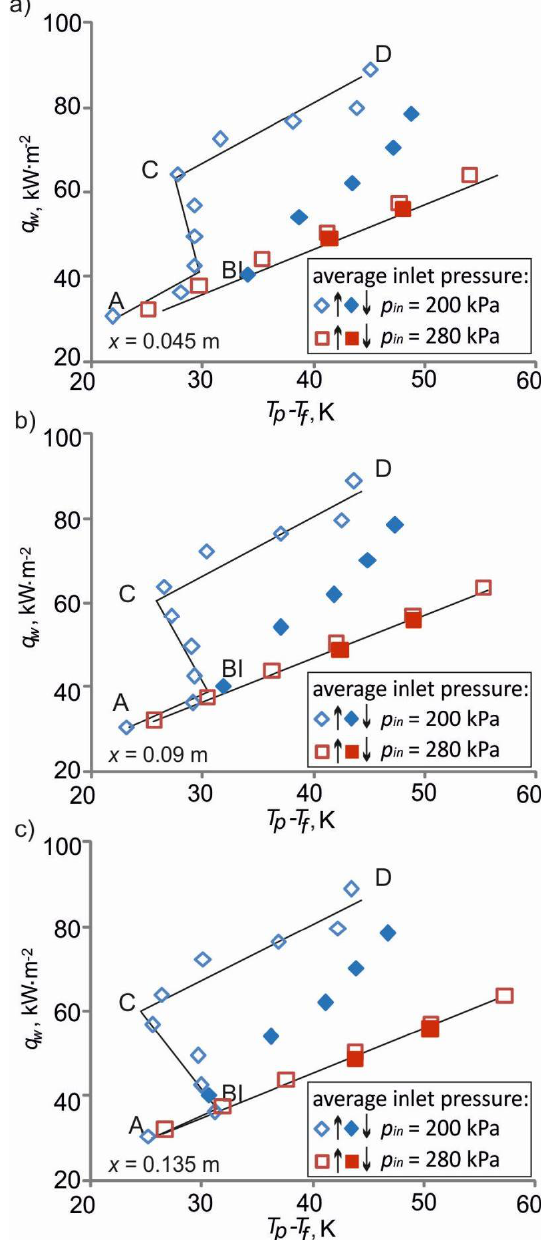
Fig. 5. Boiling curves generated for selected distances from the minichannel inlet (0.045 m, 0.09 m and 0.135 m) for two average inlet pressures, constructed as: q w vs. T p - T f , T p - heated plate temperature, T f - bulk fluid temperature.